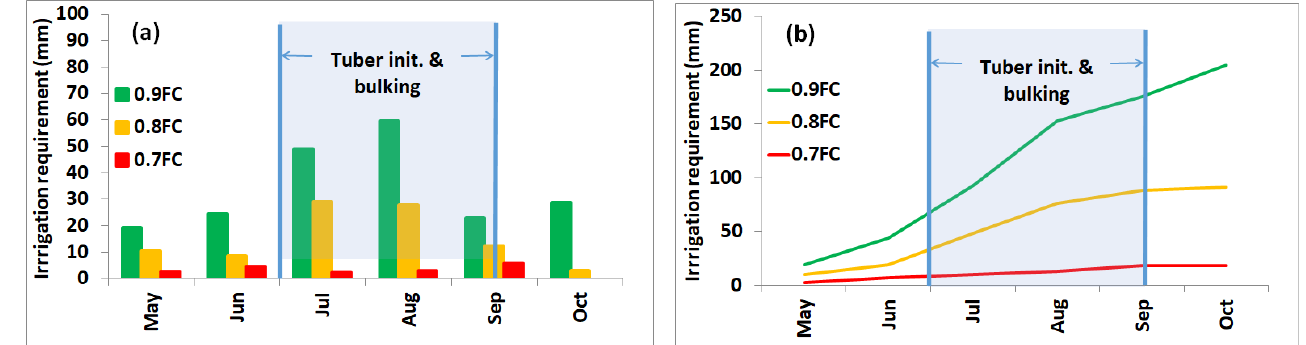
Figure 8. Monthly supplemental irrigation requirement for the various scenarios for each month ( a ) and cumulative ( b ) for the representative potato growing season.